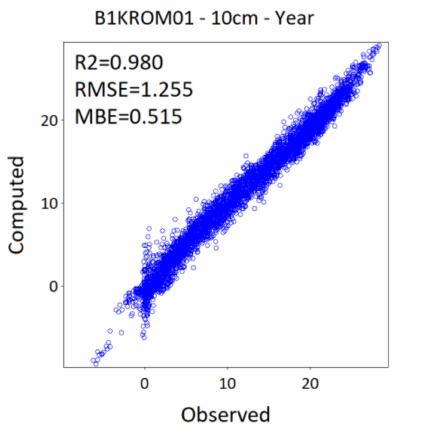
Figure A1. Validation at site B1KROM01 for 10 cm soil depth.